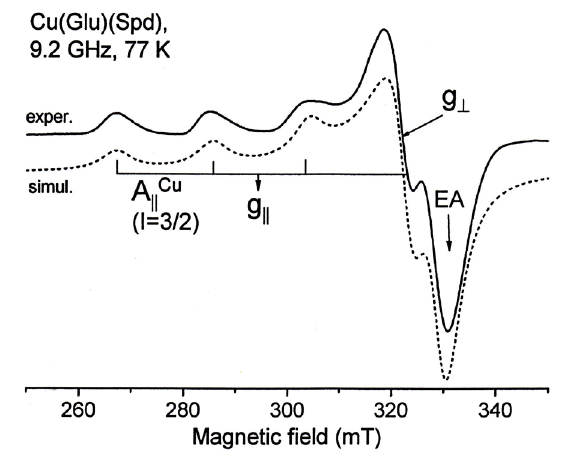
Figure 5: EPR spectra of Cu(Glu)(Spd) complex, pH = 9.5: solid line – experimental spectrum, dotted line – simulated